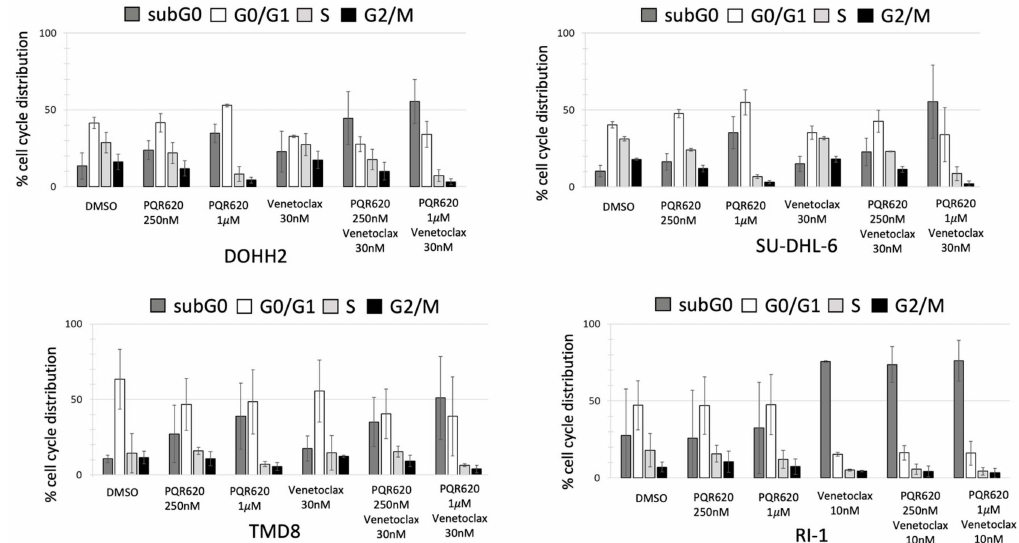
Figure 3. The combination of PQR620 and venetoclax are more in vitro cytotoxic than the single agents. Cell cycle distribution of four DLBCL cell lines (GCB: DOHH2, SU-DHL-6; ABC: TMD8, RI1) treated with two di ff erent concentrations of PQR620 (250 nM or 1 µ M) and / or venetoclax.